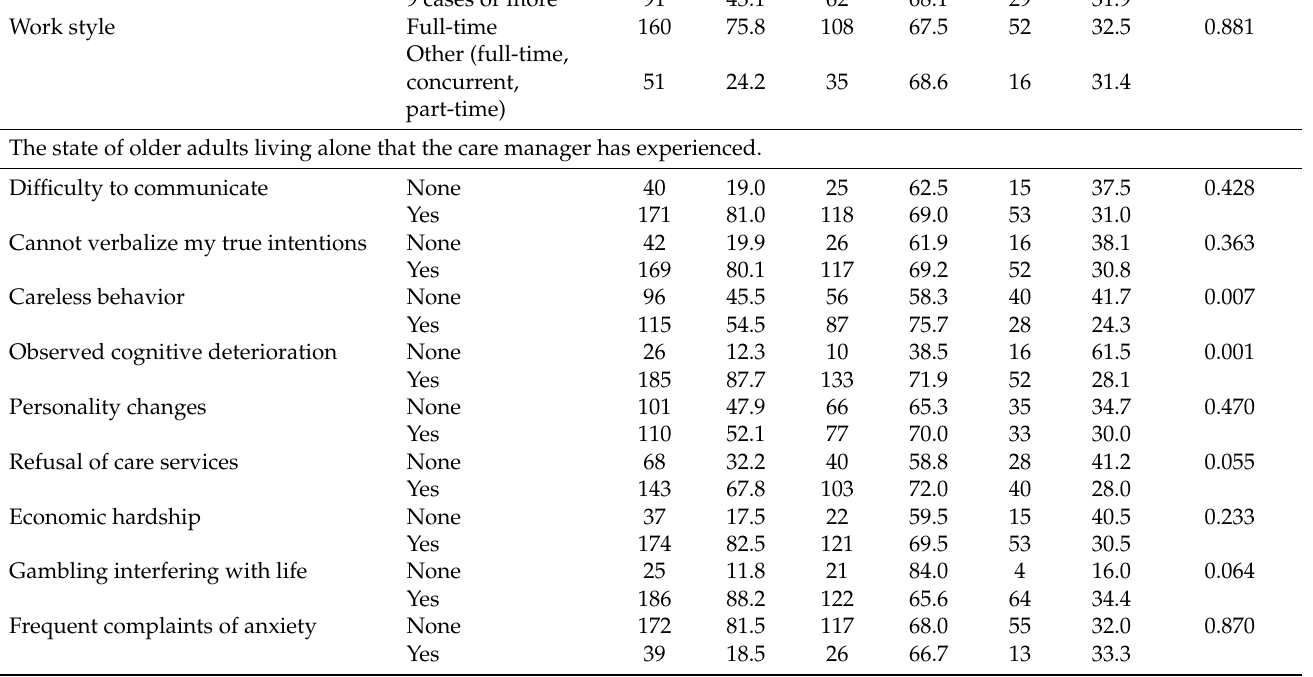
The Experience of Care Managers Making Proxy Decisions about the Direction of the Life of Older Adults Who Live Alone Whose